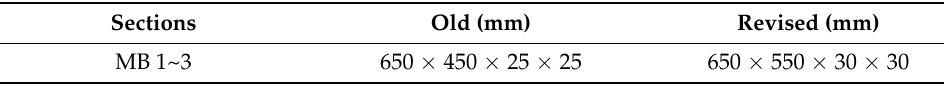
Table A9. Revised Section MB1~3.